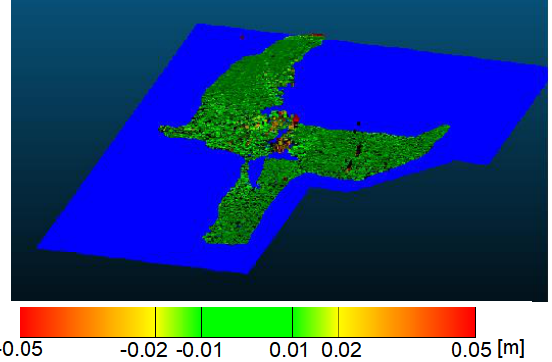
Figure 4. Example of comparison between point cloud and 3D model of the